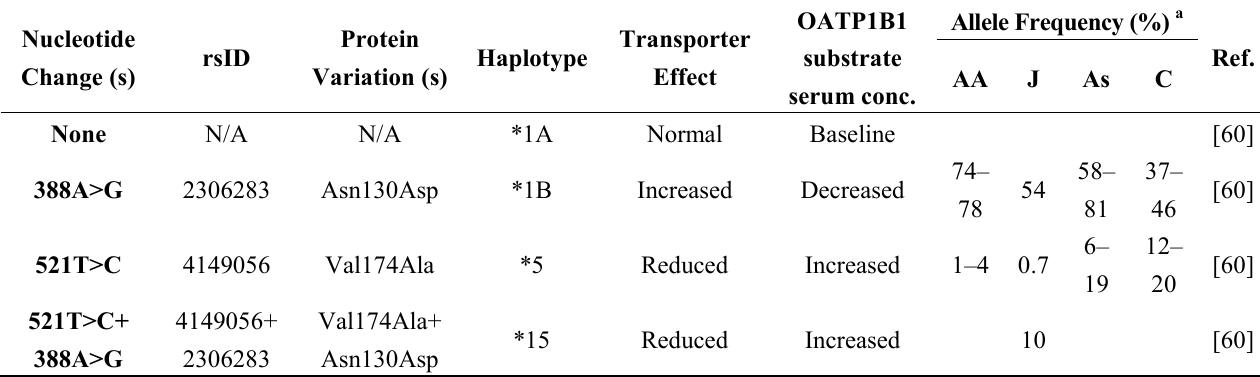
Table 3. SLCO1B1 Haplotypes in Various Ethnic Groups. Adapted with permission from Oshiro et al . [60].